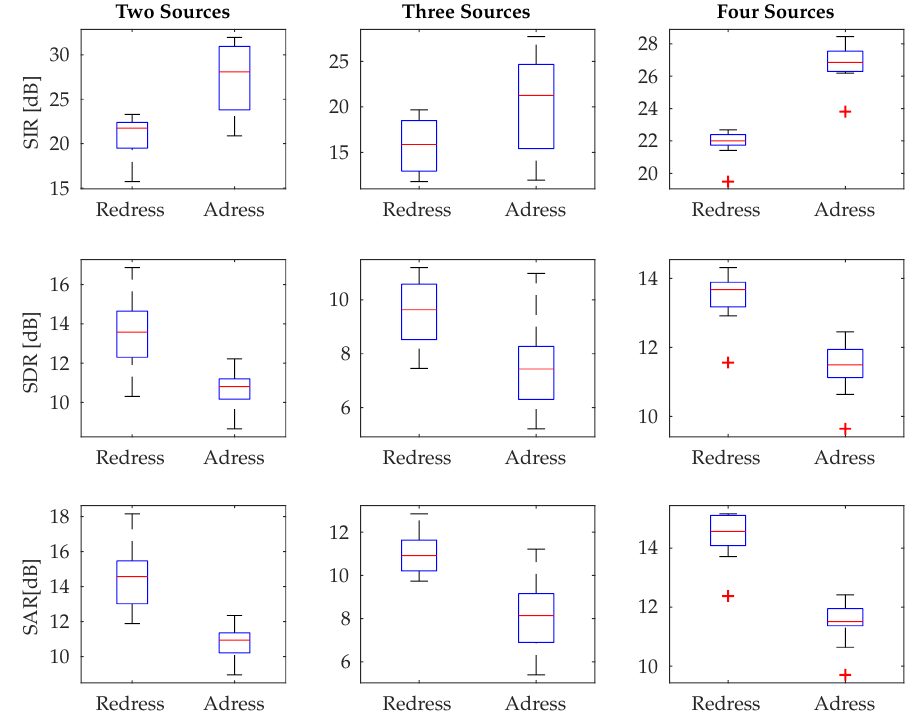
Figure 11. SDR, SIR, SAR of Redress, and Adress grouped by number of sources in the